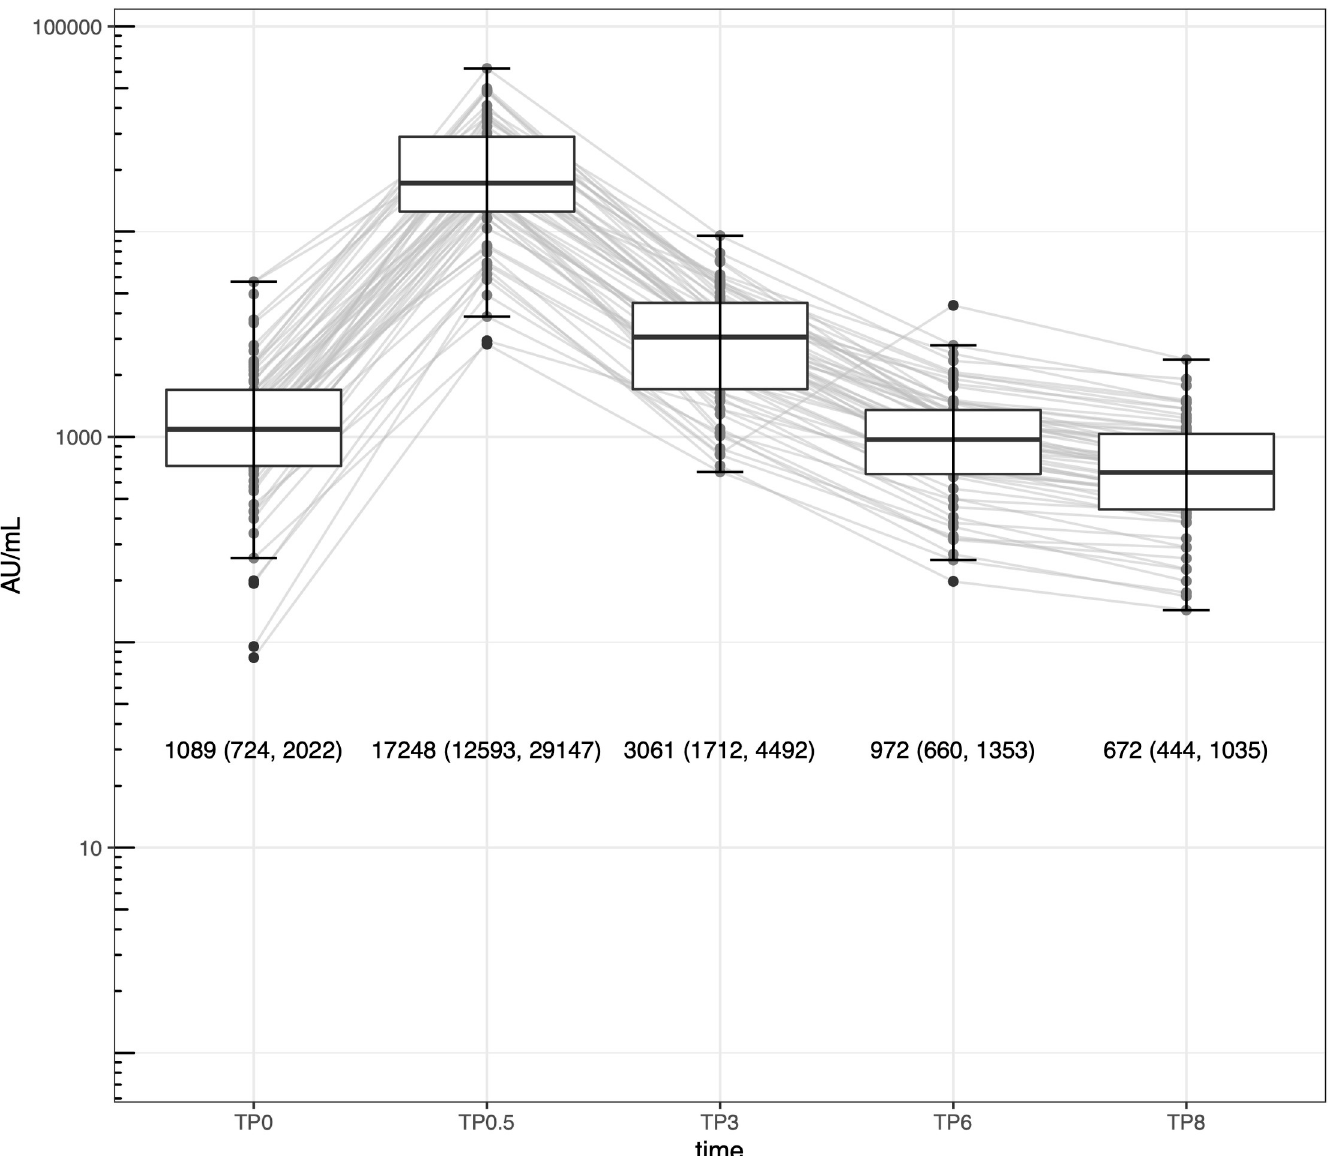
Fig 1. Serial change in spike IgG levels after two-dose BNT162b2 vaccination in 62 subjects. TP0, just before the second vaccination; TP0.5, 2 weeks after the second vaccination; TP3 (6, 8), 3 (6, 8) months after the second vaccination. Numerical values are expressed as medians (25 th percentile– 75 th percentile).